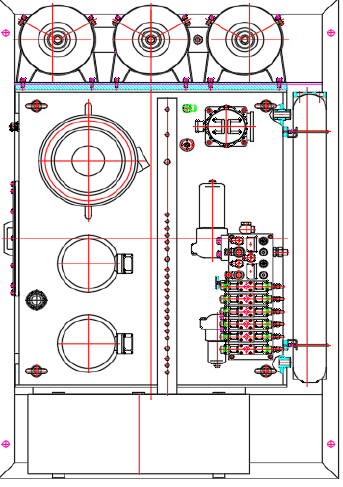
Figure 14. Hydraulic loading servo system.